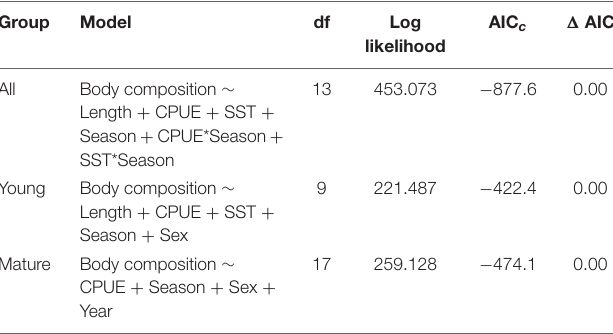
and vice versa; however, there did not appear to be a direct inverse relationship between seasonally averaged SST and